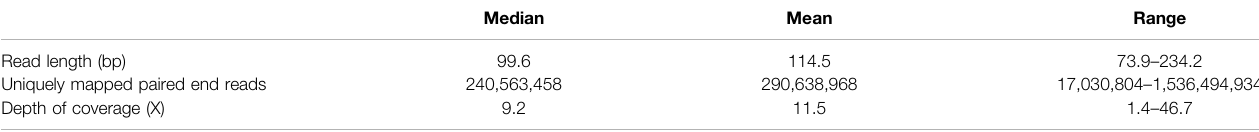
TABLE 1 | Median, mean, and range of summary statistics of the mapping pipeline derived from WGS data from 534 horses. Median Mean